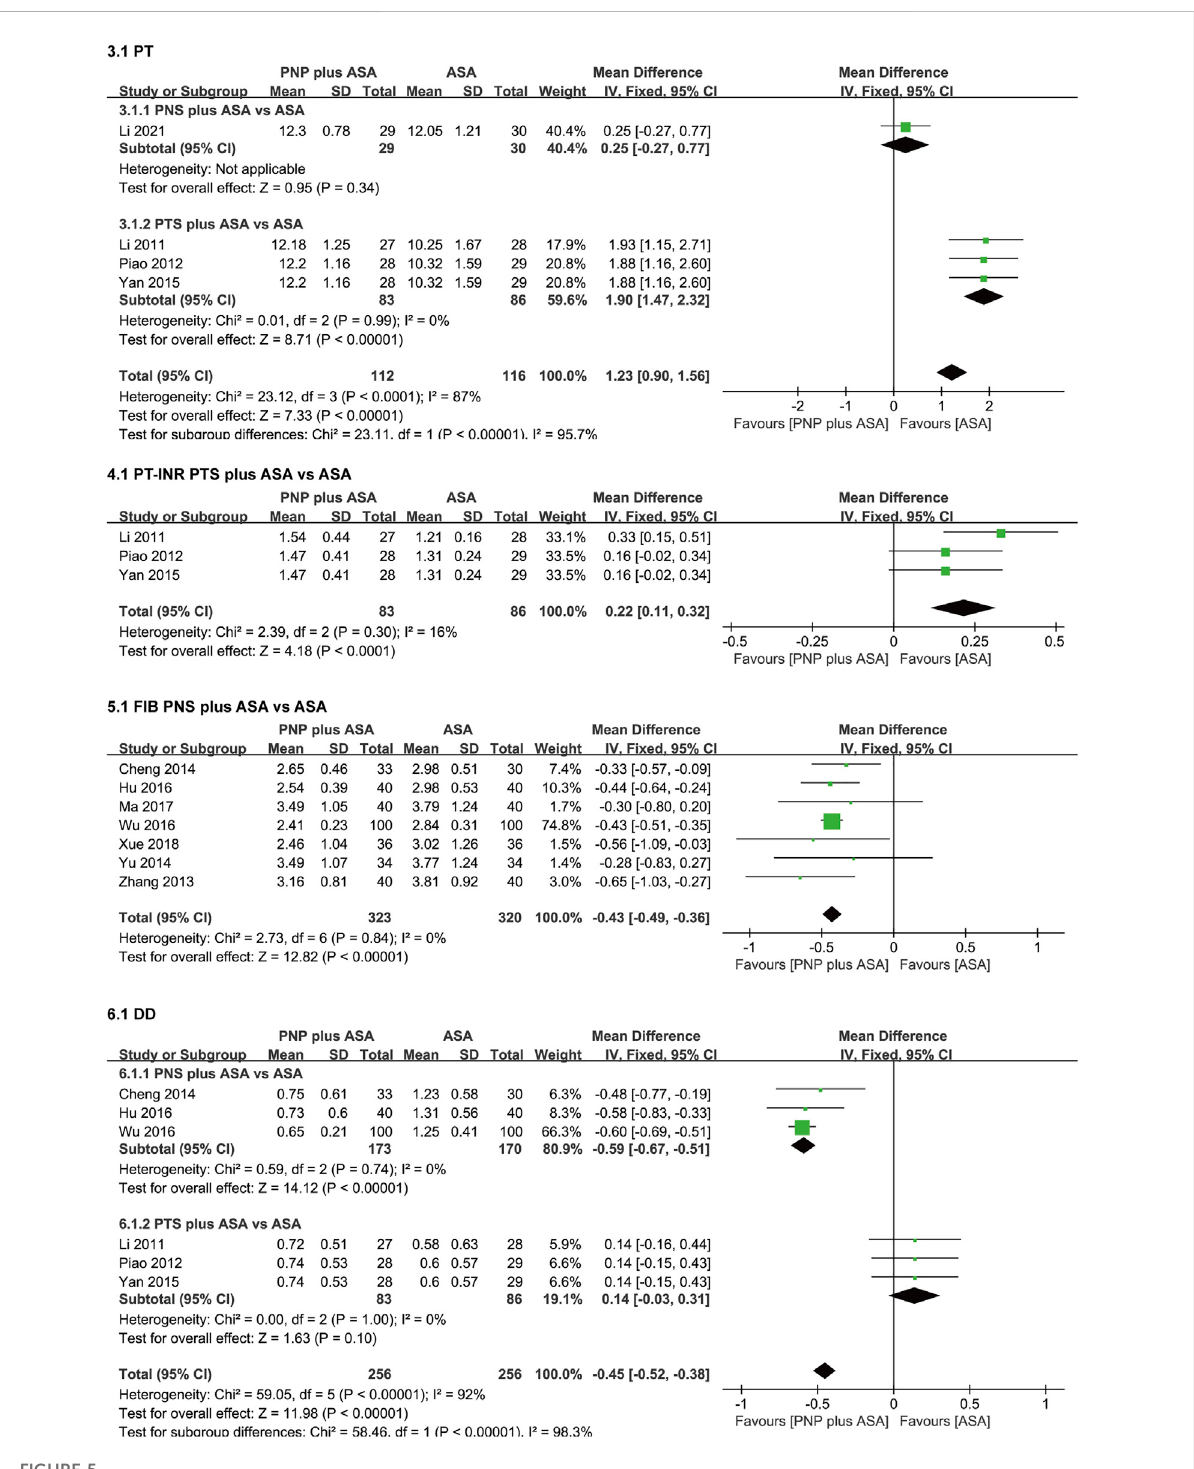
FIGURE 5 Forest plots ofPT, PT-INR, FIB, andDD. PT, prothrombin time; PT-INR, prothrombin time-based international normalized ratio; FIB, fi brinogen; DD,